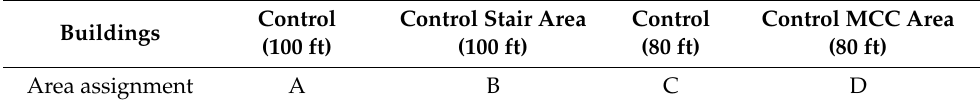
Table 5. Small flooded area selection, NPPs 3 and 4.